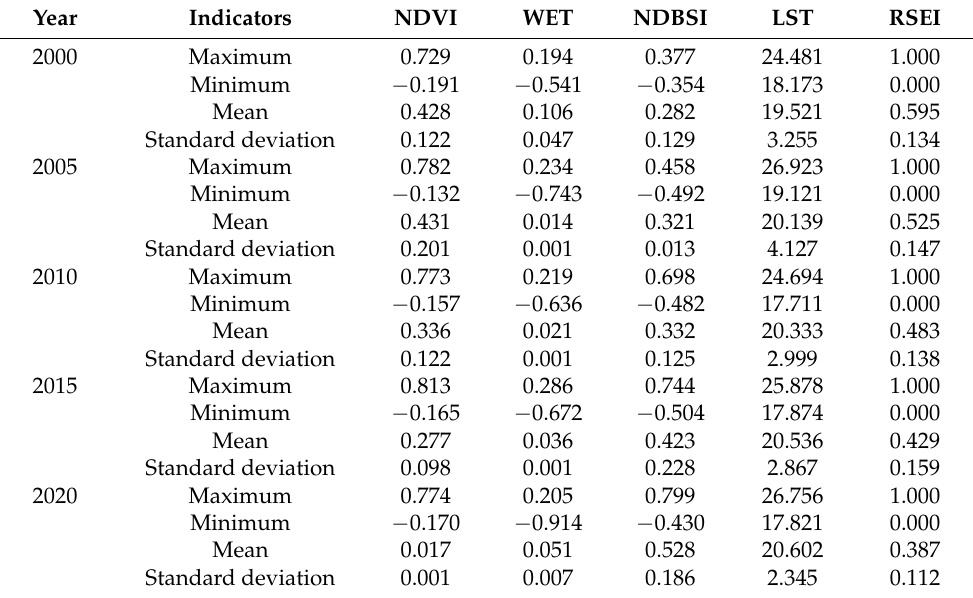
Table 2. Statistical results of the various indicators and RSEI in each